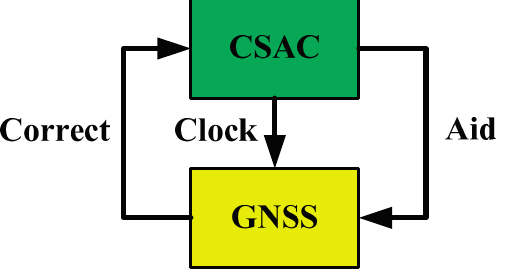
Figure 1. Coupled relationship between Chip Scale Atomic Clock (CSAC) and Global Navigation Satellite Systems